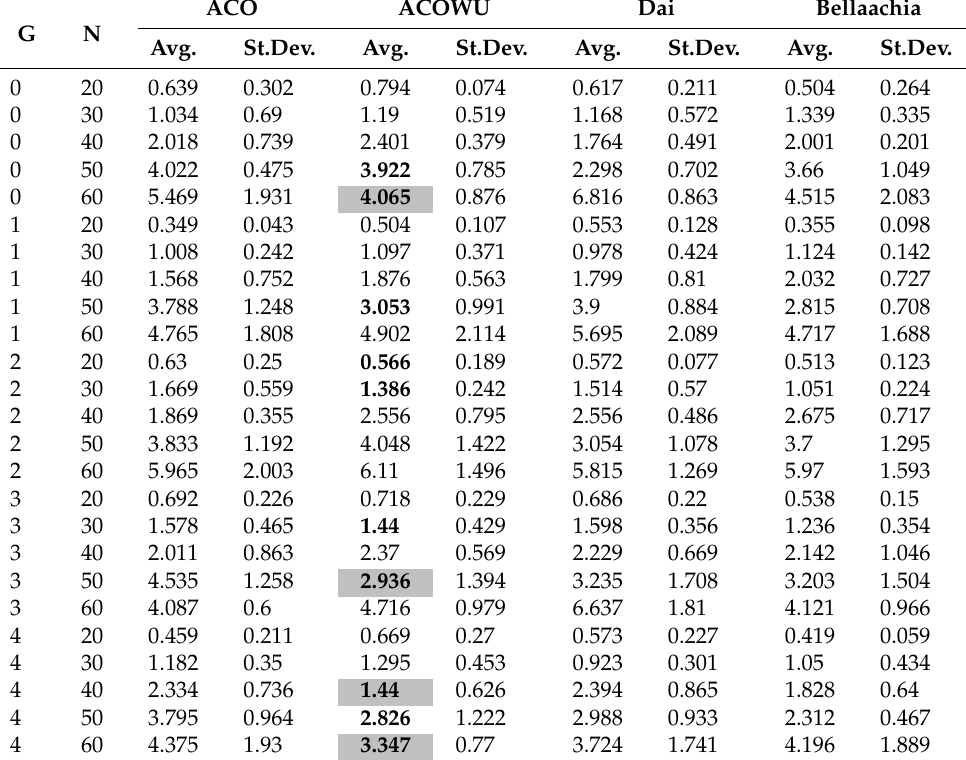
Table 4. Resultsobtained on generic TSP instances in terms of computational time.